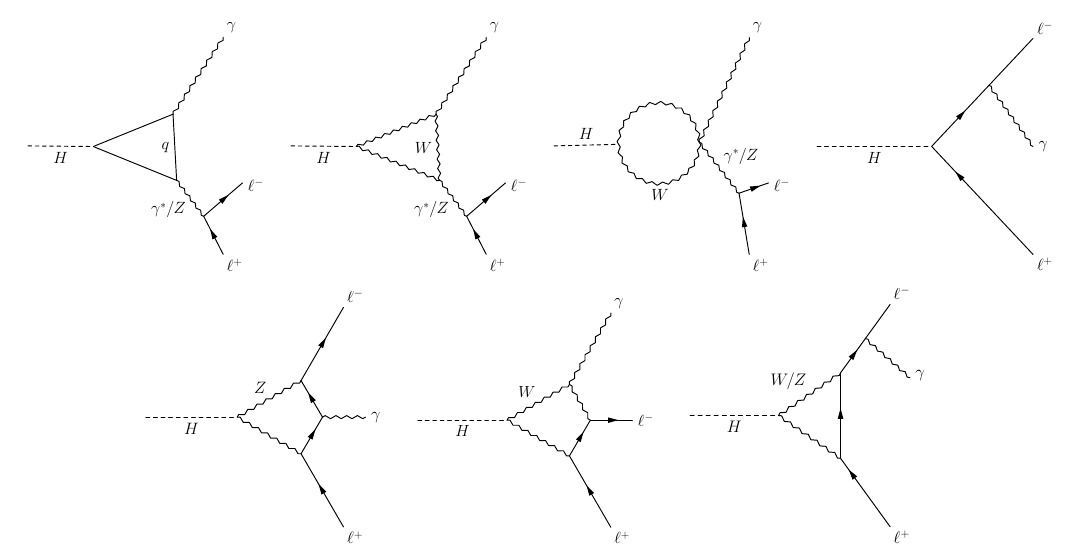
Figure 1 . Dominant Feynman diagrams contributing to the H